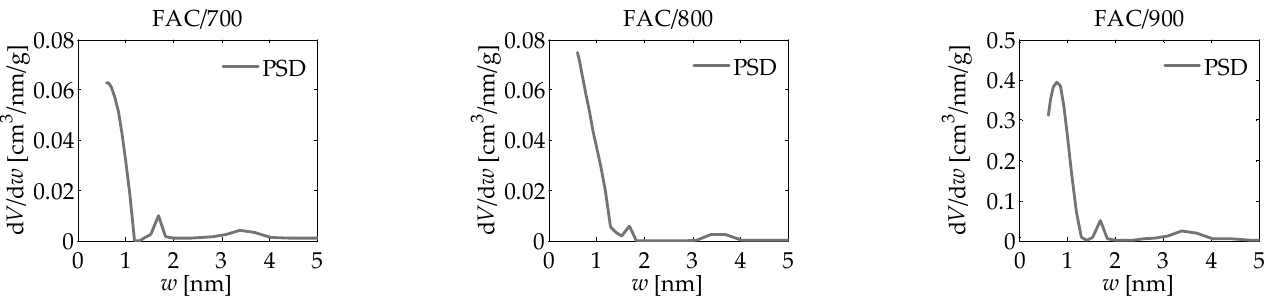
Figure 4. The pore size distributions obtained via the QSDFT method based on nitrogen adsorption isotherms for activated carbons derived from the leaves of common polypody.